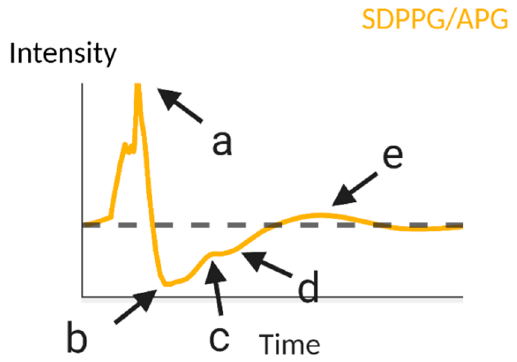
Figure 4. Five primary points of interest in an acceleration plethysmograph (PPG 2nd derivative). Created with BioRender.com.